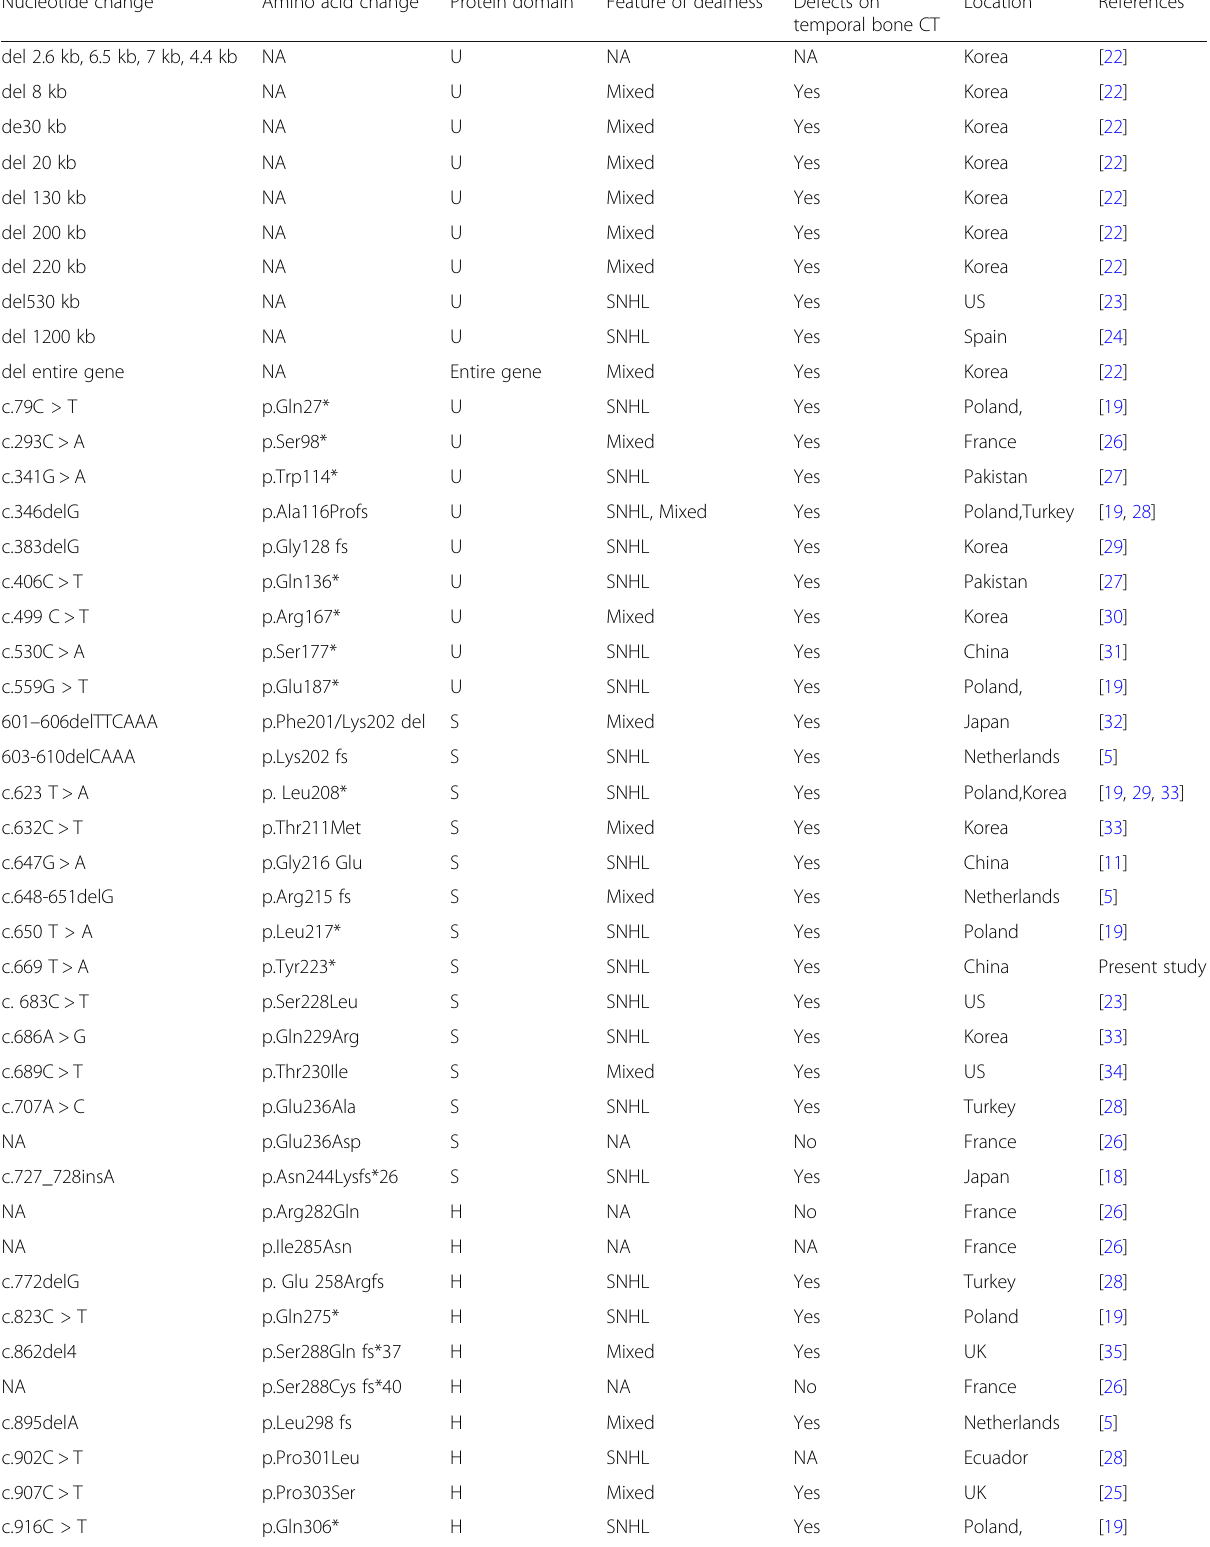
Table 1 Reported Mutations in the POU3F4 Gene Resulting in DFNX2 Phenotypes Nucleotide